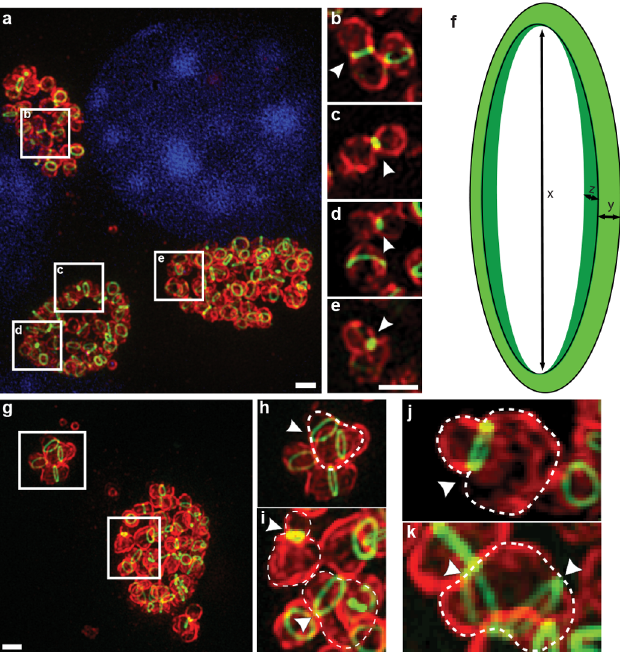
Fig 4. 3D SIM visualization of labeled chlamydial PG. (a-e) Maximum intensity projection (7 μ m thick Z stack) of C . trachomatis incubated with 4 mM EDA-DA at 2 hpi and fixed at 18 hpi. Panels ( b-e) are maximum intensity projections of 0.5 μ m thick planes of interest selected from panel a . Arrowheads indicate areas of punctate PG staining (as opposed to PG rings). (f) The PG ring dimensions: diameter x, width y, and thickness z. (g-k) 3D-SIM of cases of asymmetric cell division are outlined and marked with arrowheads for clarity. Panels (h) and (i) are magnifications of the image in panel (g). Images in panels (j) and (k) are independent cases. MOMP and PG labeling is the same as in Fig 2. Image is representative of ~ 20 inclusions analyzed. Scale bar = 1 μ